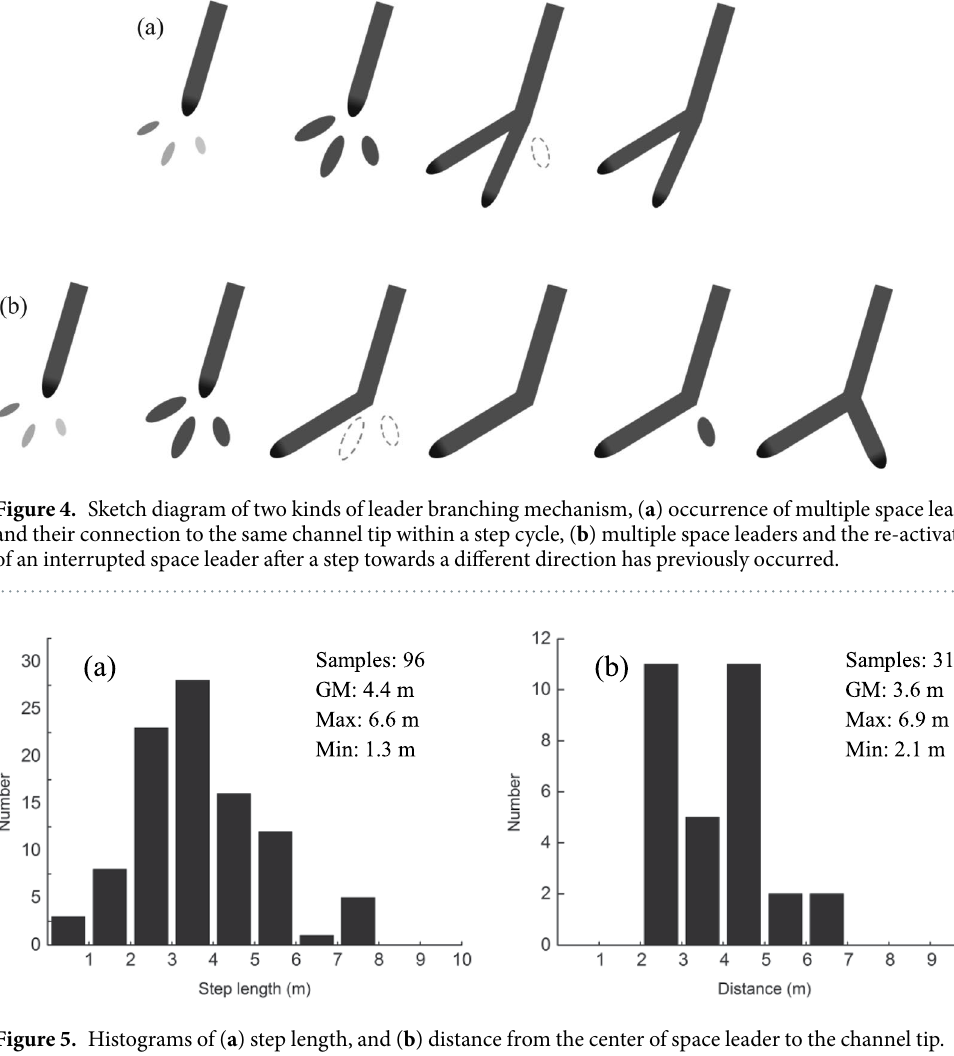
to the channel tip are calculated. Figure 5 shows the distributions of these two parameters. The step length ranges from 1.3 m to 8.6 m and the geometric mean is 4.4 m (4.6 m on average). For 31 samples of the distance between the center of space leader and the channel tip, the geometric mean is 3.6 m (3.8 m on average), and it varies in the range of 2.1–6.9 m. Since the space leader with detectable luminosity lasts a very short time while evolving from space stem and it persistently grows in length, it does not make much sense to analyze the segment length or the gap length between the segment and the main channel at the moment when the segment is captured in a frame. These two values may vary as the space leader develops. By comparing the 2-D results in this paper with the pre- vious observations 5, 12–14, 21, 22 , the step-length herein is more or less consistent with that obtained by Hill et al . 11 , giving an average value of 5.2 m under an estimated observing distance of 1 km. Biagi et al . 21 reported five steps in an altitude-triggered lightning to range in 5–8 m, with similar upper value to our result. By using a photodiode array photographic system, Chen et al . 22 observed two negative leaders with mean step length of 13.3 m (ranged in 7.9–19.8 m) and 8.5 m, respectively, larger than the results in this paper. Figure 6a further shows the scatter plot of the 96 steps relative to the tip of the leader trunk. The scatter points represent the direction and step length (distance from the tip) of each individual steps as they jumps downward from the descending channel tip, and the color bar gives the relative time of their occurrence during a 667- µ s period. The direction (or the angle) of the scatter points relative to the leader tip shown in the figure is obtained by comparing the new step with the prior step, which means a relative angle in regard to the advancing direc- tion of the existing channel when the new step occurs by junction of space leader to the tip. As indicated in the figure, the direction of the steps is quite random, with the maximum relative angle up to about 90°, the straight forward direction from the tip does not involve significant ascendency for an individual step to jump towards. Nevertheless, within an angle range of ± 30° ahead from the channel tip, the step probabilities are indeed larger. More than 50% of all the steps occurs in such a 1/3 region in front of the channel tip. It seems that the step-length of the leader does not exhibit an obvious increasing tendency as it gets closer to ground with time, although in the